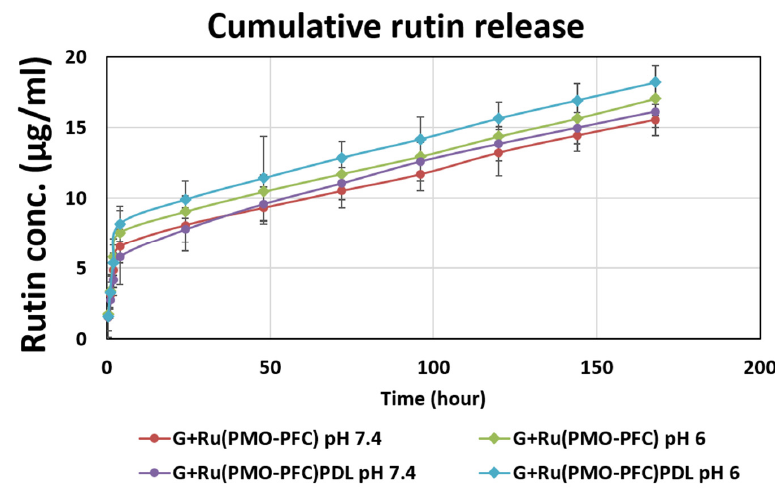
Figure 5. Rutin release ( μ g/mL) from NC ‐ hydrogel scaffolds at pH 7.4 and pH 6.